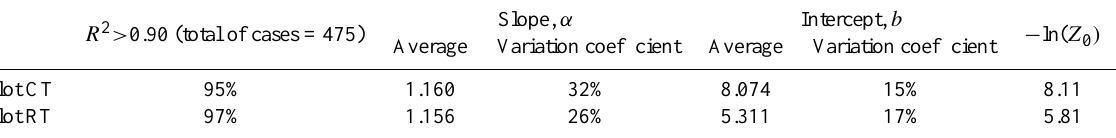
/U 2 ∗ = f (ln( z ))= α ln( z )+ b , using the values of U ∗ stemming from the MW method. h